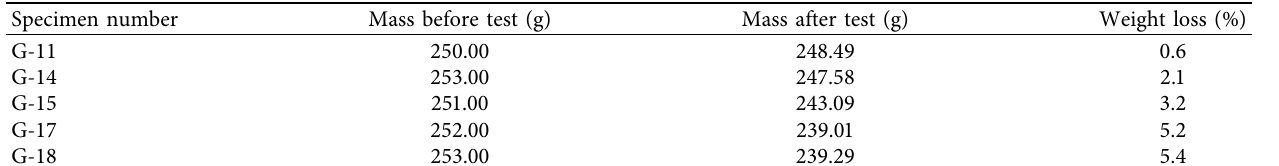
Table 4: Mass of specimens before and after test.